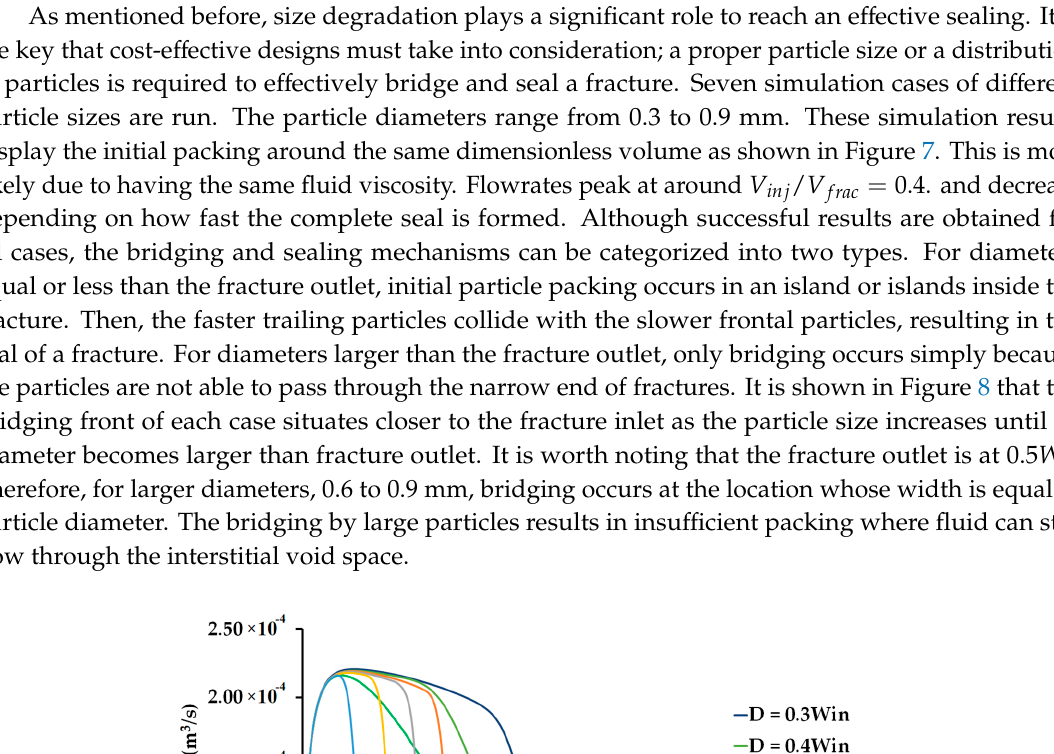
Figure 6. Turbulent flow attributed to the ultra-low fluid viscosity.